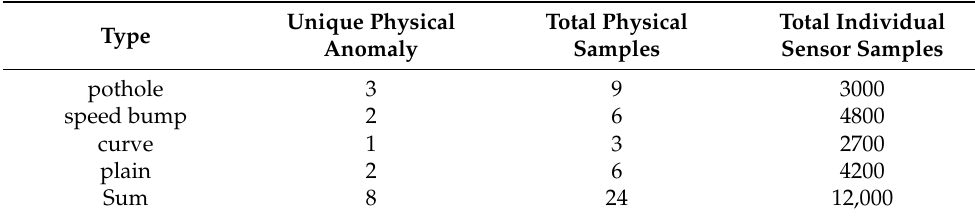
Table 4. Classification of acquired